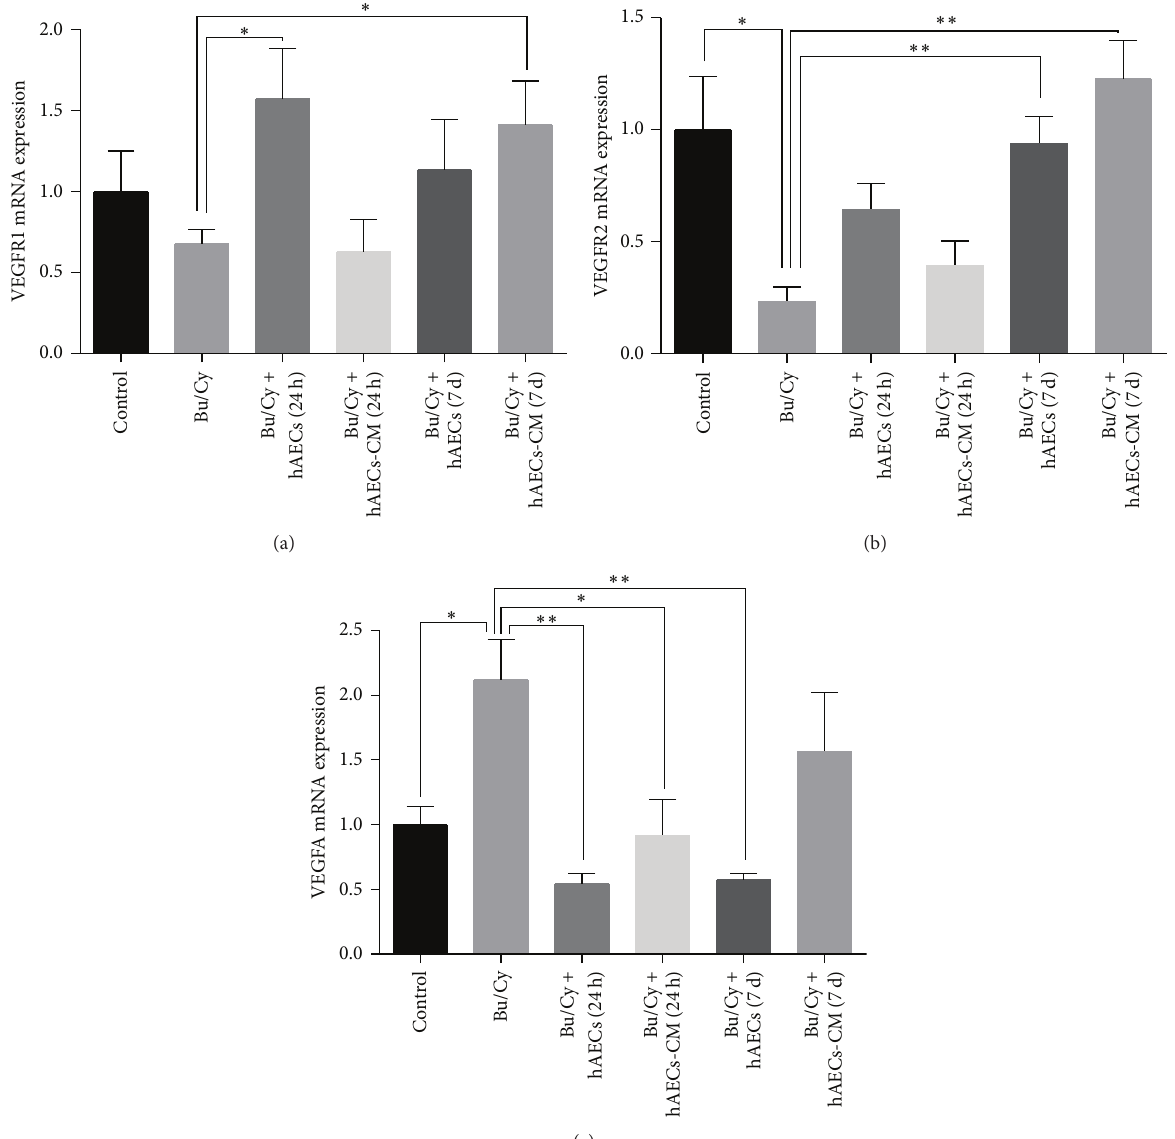
However, 1 month after treatment, levels of ovarian MVD